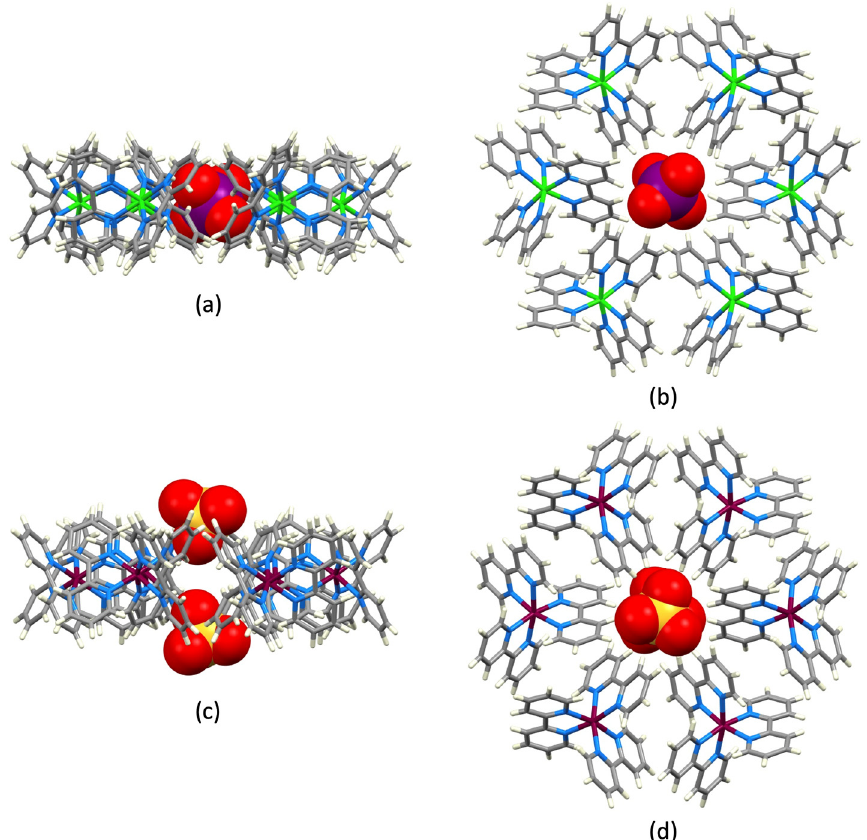
Figure 8. Structure Types I and II for [XY 4 ] 2– containing compounds: ( a , b ) Structure Type I with the motif found in [Zn(bpy) 3 ][CrO 4 ] 0.5 [NO 3 ] . 6.5H 2 O (refcode XUJDEL) [29], and ( c , d ) structure Type II illustrated with the motif in [Cu(bpy) 3 ][SO 4 ] . 7.5H 2 O (refcode ROLLOU) [56].